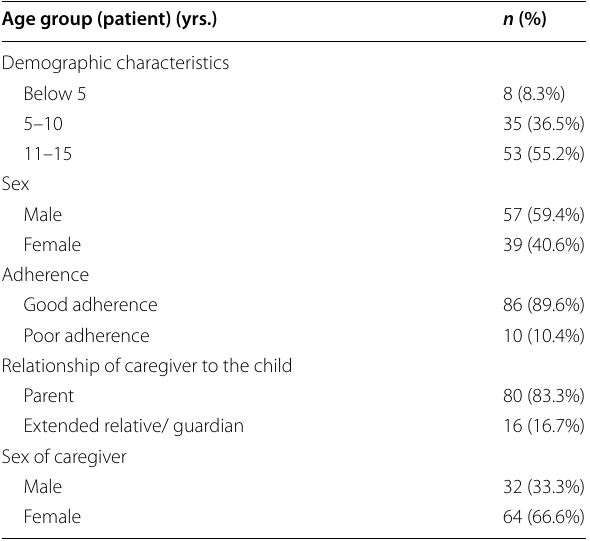
Table 3 Table showing the adherence to ART in association with different factors